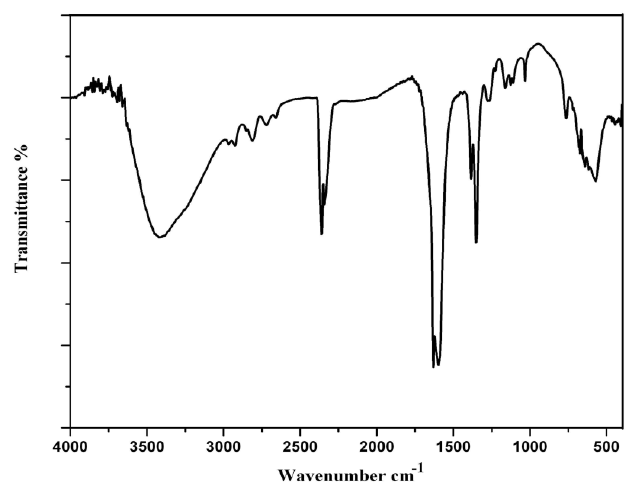
Figure 2. FTIR spectrum of synthesized magnetite nanoparticles using [BMIM][TfO] ionic liquid.